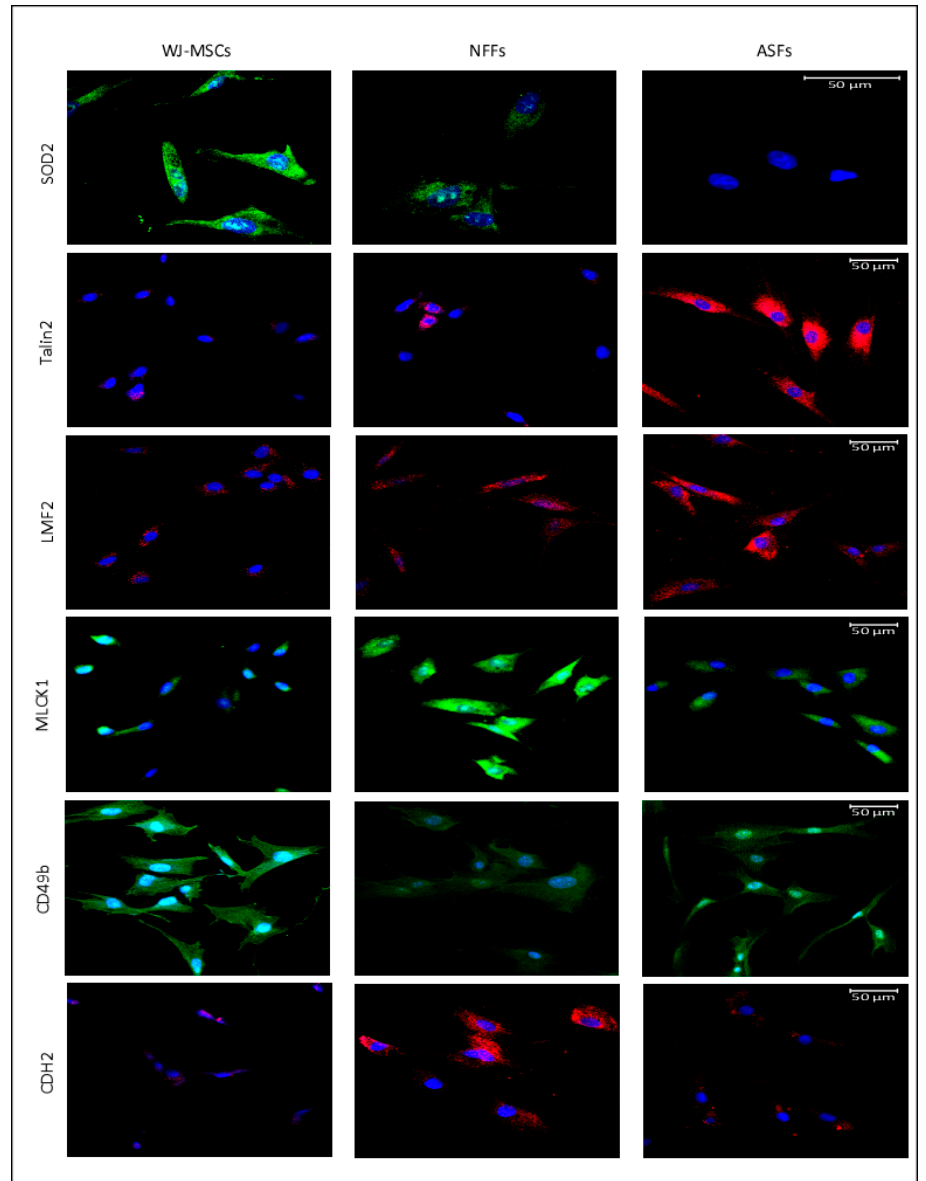
Figure 5. Immunofluorescence of selected proteins expressed in WJ-MSCs, NFFs, and ASFs. Representative confocal laser microscopy images of immunofluorescence for primary cells using APEX antibody labeling system for conjugating the indicated primary antibodies as described in the Materials and Methods Section. Shown at 400× magnification. Nuclei were stained with 4 ′ ,6- diamidino-2-phenylindole